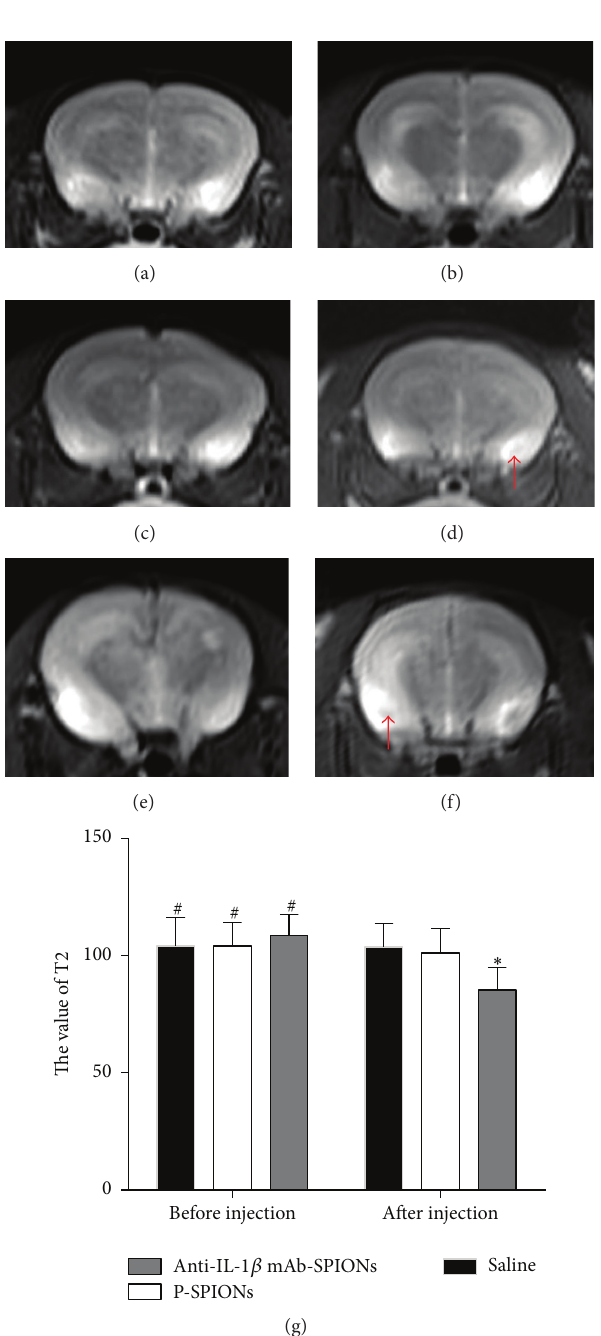
Figure 1: MR images of rat brains in the three groups are shown before and after tail vein injection of particles (15mg/kg). ((a), (c), and (e)) Baseline MRI prior to injection with saline, P-SPIONs, anti-IL-1 𝛽 , and mAb-SPIONs; (b) MR images acquired 4 h after saline injection. (d) MR image acquired 4 h after P-SPIONs injection; area of negligible negative enhancement is not visible (red arrow). (f) MR images acquired 4 h after anti-IL-1 𝛽 mAb-SPIONs injection; area of negative enhancement is visible (red arrow) in CA3 showing unilateral uptake of particles; (g) the changes in the value of T2 before and after injection in the three groups. Data represent mean ± SD of 10 pilocarpine-SE rats per group. ∗ 𝑃 < 0.05 versus preinjection. # 𝑃 > 0.05 between three groups when